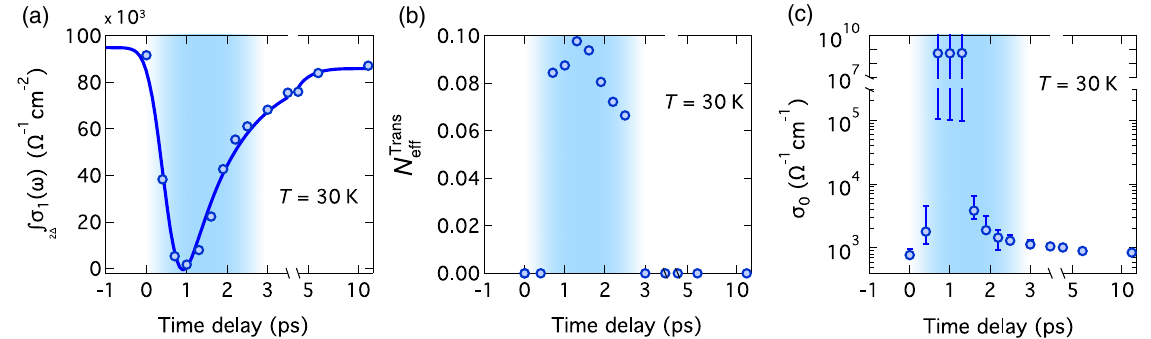
FIG. 5. (a) Dynamical evolution of the transient spectral weight in the real part of the optical conductivity as a function of pump-probe time delay. (b) Time evolution of the effective number of “ condensed ” carriers per unit cell in the transient state, N Trans evolution of the zero-frequency extrapolation of the optical conductivity, σ 0 ¼ σ 1 ð ω Þj ω → 0 , extracted from Drude-Lorentz fits of the transient optical properties. Data have been taken at T ¼ 30 K after vibrational excitation with a pump fluence of 2 mJ = cm 2 .